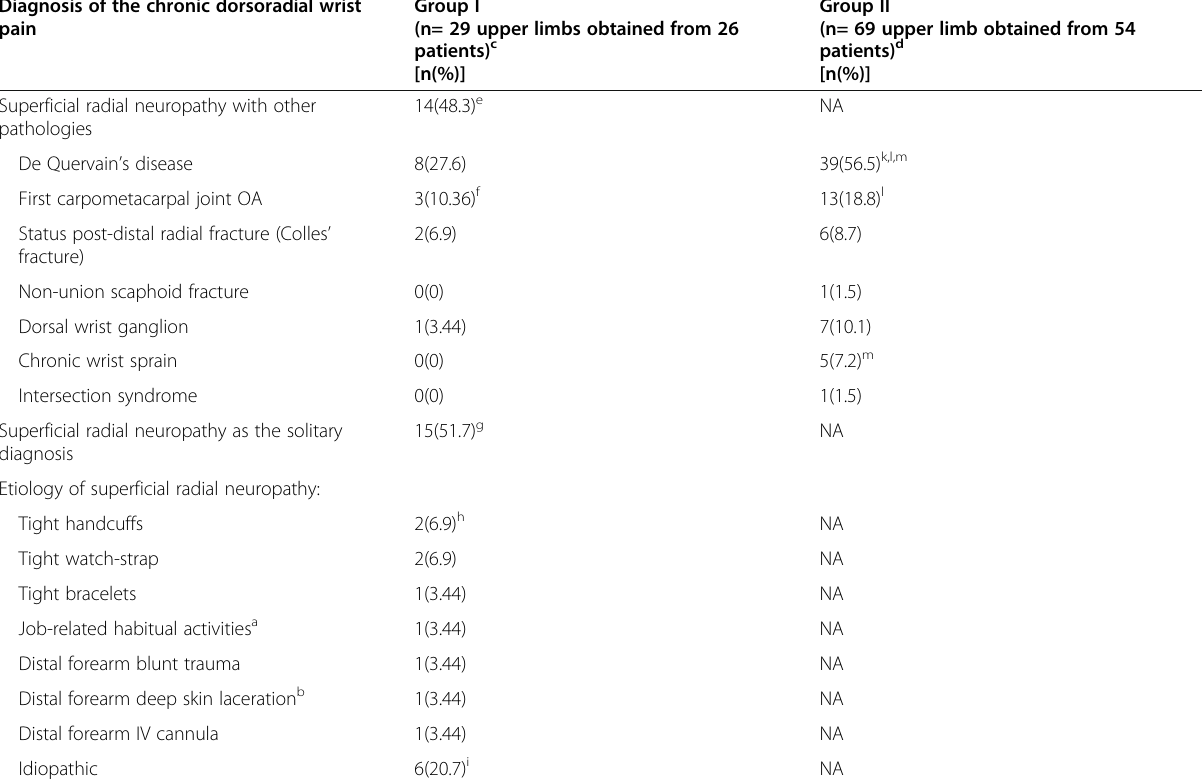
Table 4 Diagnosis of patients with chronic dorsoradial wrist pain in both patients ’ groups Diagnosis of the chronic dorsoradial wrist pain